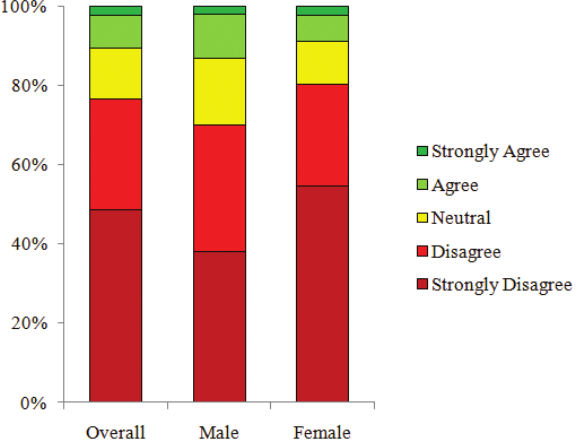
Figure 9. Cumulative responses to B3: “The construction of Roop - pur Nuclear Power Plant (RNPP) will be free from corruption”.